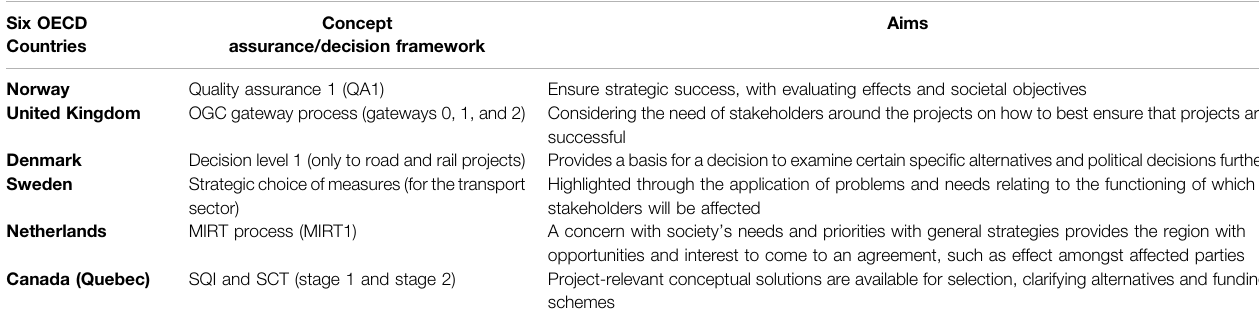
FIGURE 2 | The research framework for governance context.